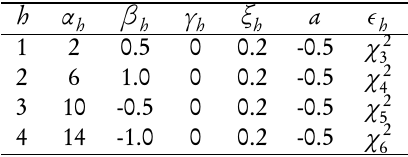
Parameter settings for generated finite Population